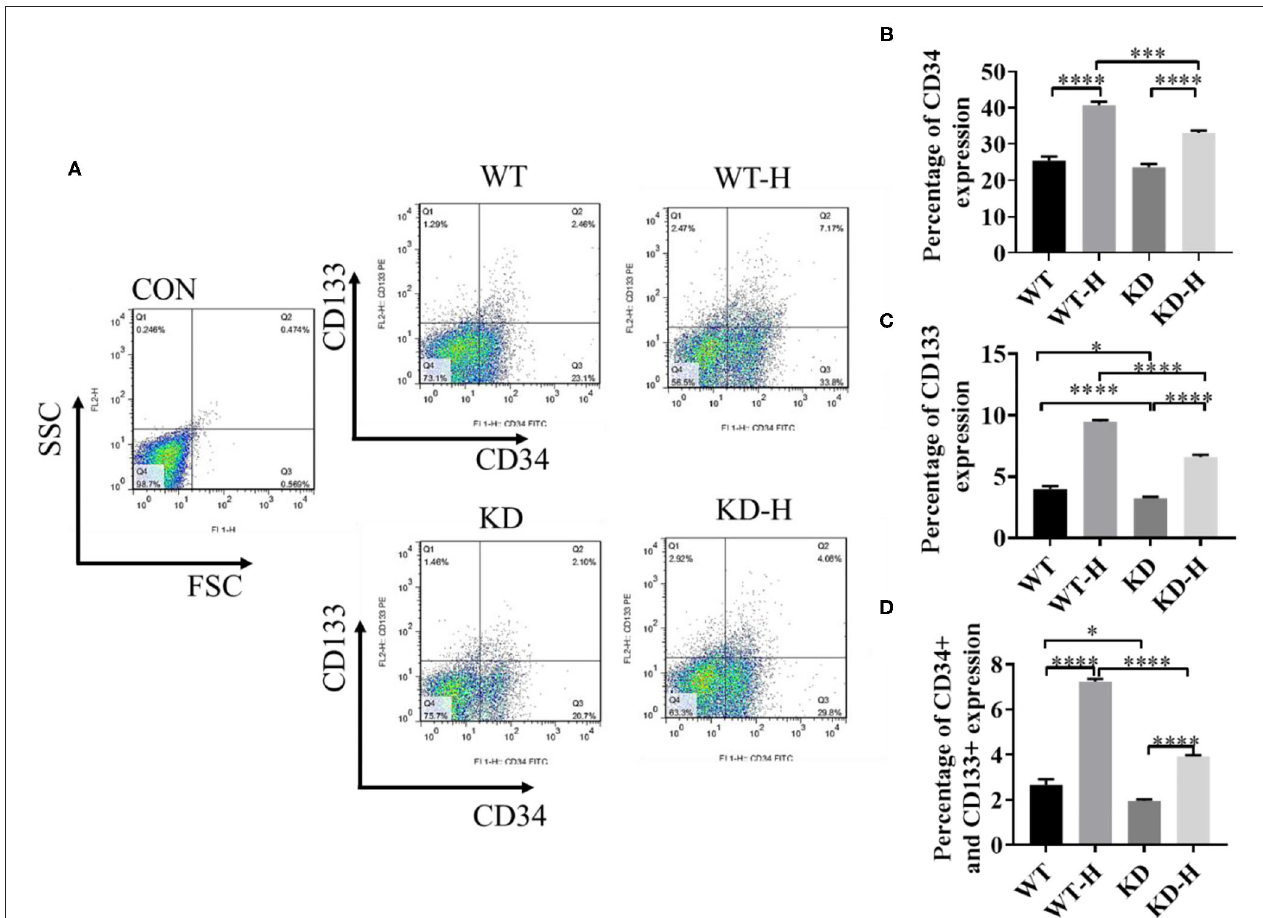
FIGURE 4 | Effect of gamma-aminobutyric acid type B receptor subunit 2 (GABBR2) knockdown on endothelial progenitor cell (EPC) mobilization in peripheral blood in hindlimb post-ischemia. (A) Representative images of CD34 + /CD133 + cells in the peripheral blood of mice analyzed by flow cytometry. WT , normal mice; KD , GABBR2-downregulated mice; WT-H , wild-type (WT) mice with hindlimb ischemia; KD-H , GABBR2 knockdown (KD) mice with hindlimb ischemia. (B) Ratio of CD34 + cells in the peripheral blood of normal and ischemic mice. (C) Ratio of CD133 + cells in the peripheral blood of normal and ischemic mice. (D) Ratio of CD34 + and CD133 + cells in the peripheral blood of normal and ischemic mice. * p < 0.05; *** p < 0.001; **** p <